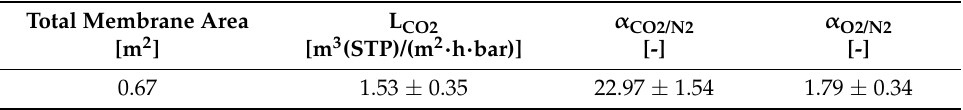
Table 4. Average CO 2 permeance, CO 2 /N 2 selectivity and O 2 /N 2 selectivity of SILM envelopes ( ϑ = 20 ◦ C, ∆ p = 2 bar).